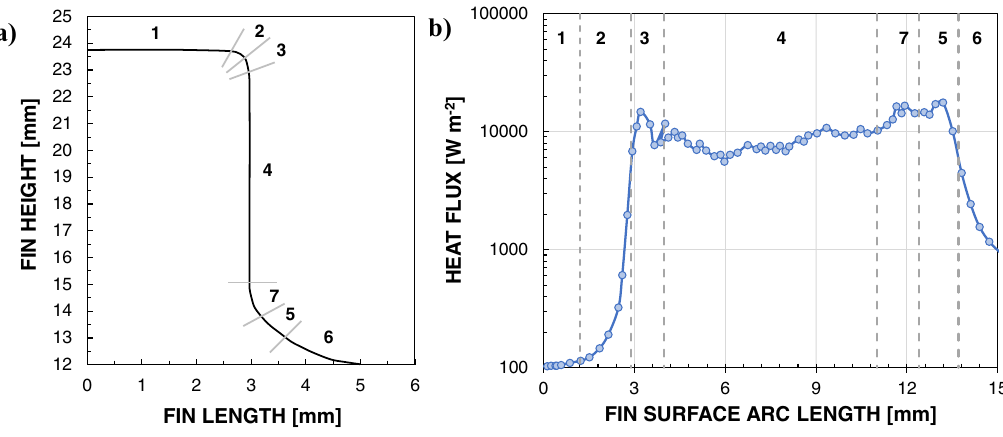
Fig. 8 Condensation heat transfer on a fi n surface under normal gravity. Heat fl ux distribution ( b ) under normal gravity for each selected area of the fi n ( a ) (Glushchuk et al. 70